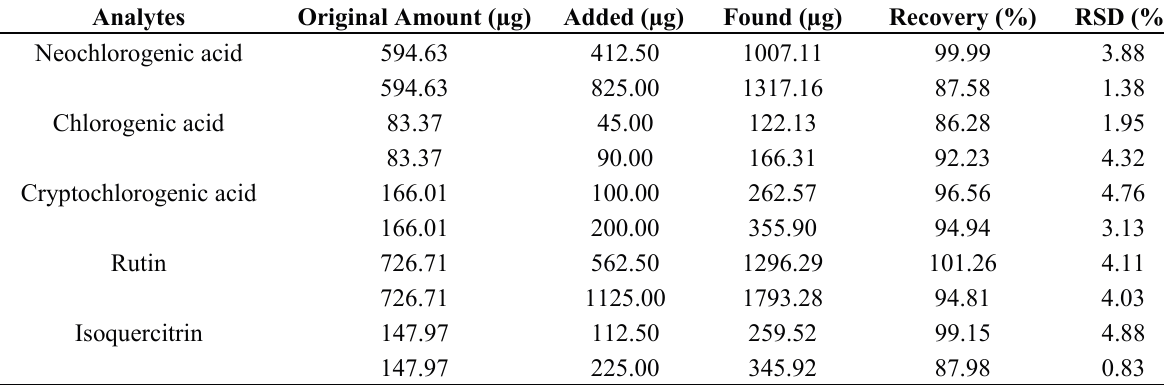
Table 3. Recovery test of the five compounds in H. sabdariffa leaves ( n =